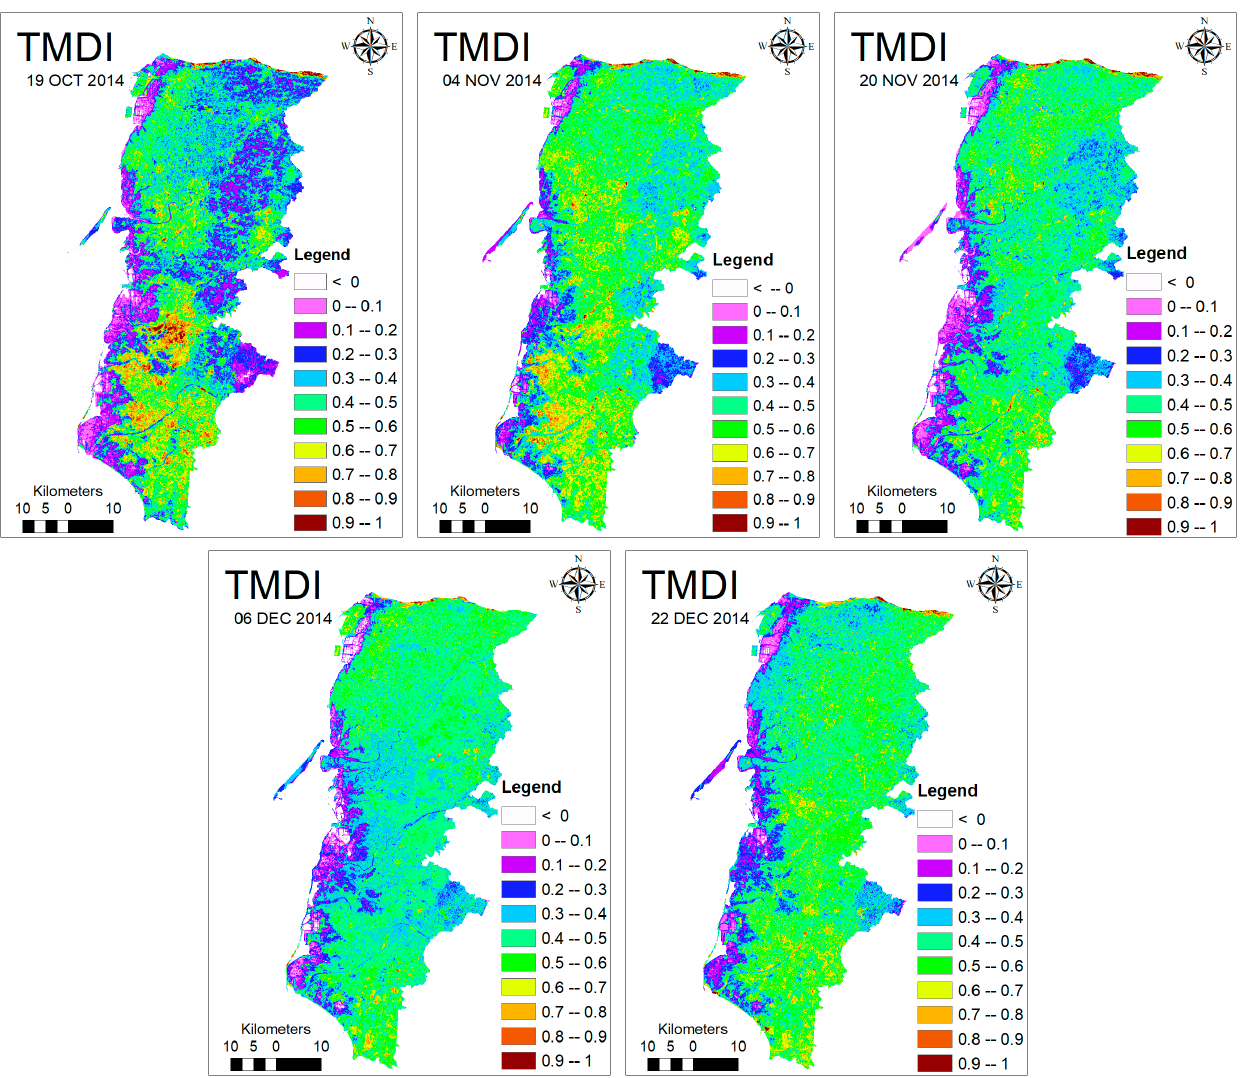
Figure 5. Temperature-soil Moisture Dryness Index ( TMDI ) over Yun-Chia-Nan on 19 October, 4 November, 20 November, 6 December, and 22 December 2014 .